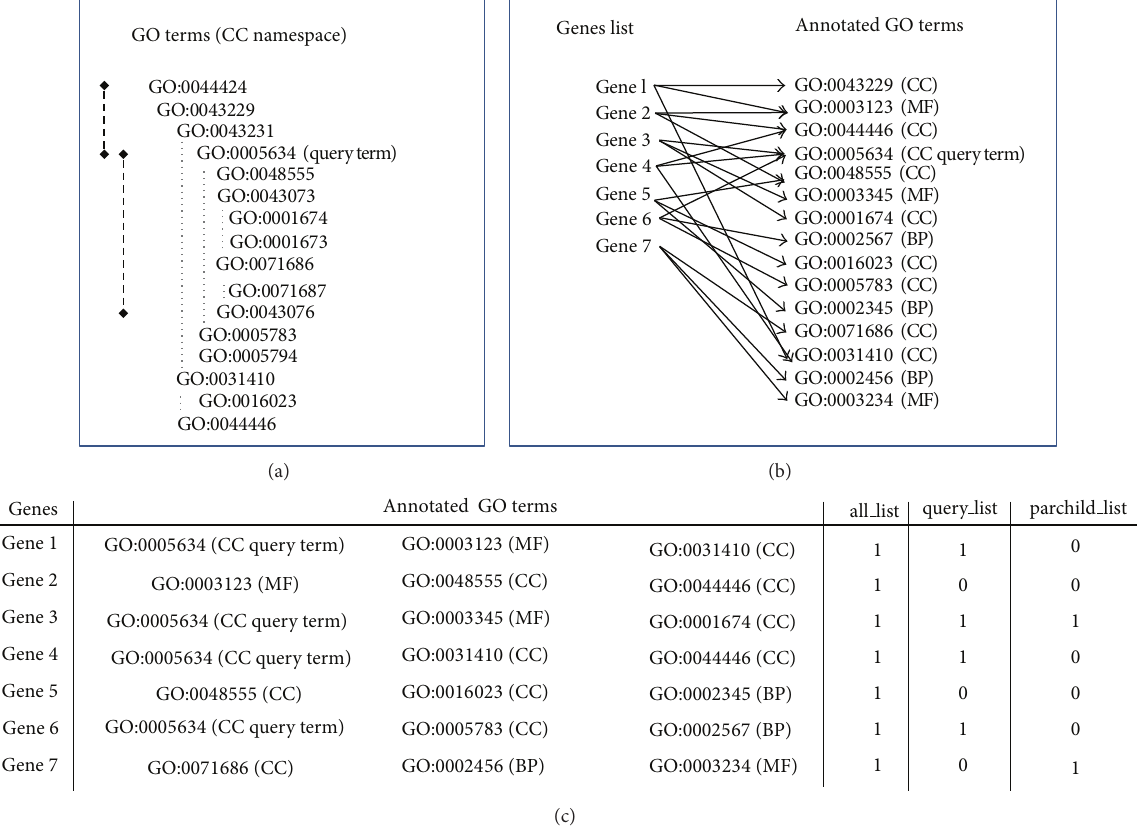
Figure 1: Summary of the GOLink stepwise protocol. (a) Simplified tree of a section of the Cellular Component (CC) GO DAG. The child terms of a supplied “query term” GO:0005634 (nucleus) are shown by the long black dashed line and its parents by the short black dashed line. (b) The GO terms used to annotate all genes annotated with the query term or any of its child terms are retrieved. Shown are the relationships between 7 genes and their corresponding GO annotation. The namespace to which a term belongs is indicated by the braced abbreviations Cellular Component (CC), Molecular Function (MF), and Biological Process (BP). (c) Summary of GO term annotation for each gene